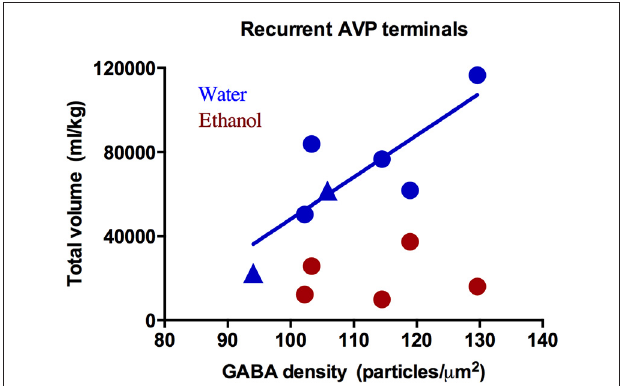
FIGURE 4 | GABA immunogold density (particles/ µµµ m 2 ) in recurrent arginine-vasopressin (AVP) axon collaterals correlates with water intake (blue: R 2 = 0.82, p = 0.03) but not ethanol (red: R 2 = 0.10, p = 0.88). Circles: drinkers, triangles: controls. Only two of the three controls were included in analysis of immunogold density and AVP due to a technical error in tissue